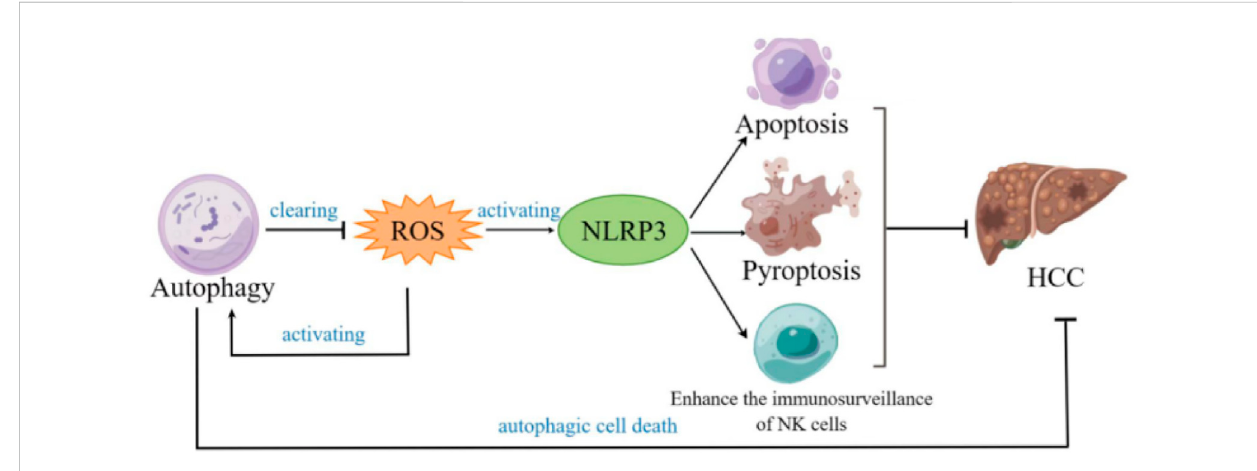
FIGURE 2 Diagram of the role of autophagy, NLRP3 and reactive oxygen species (ROS) in hepatocellular